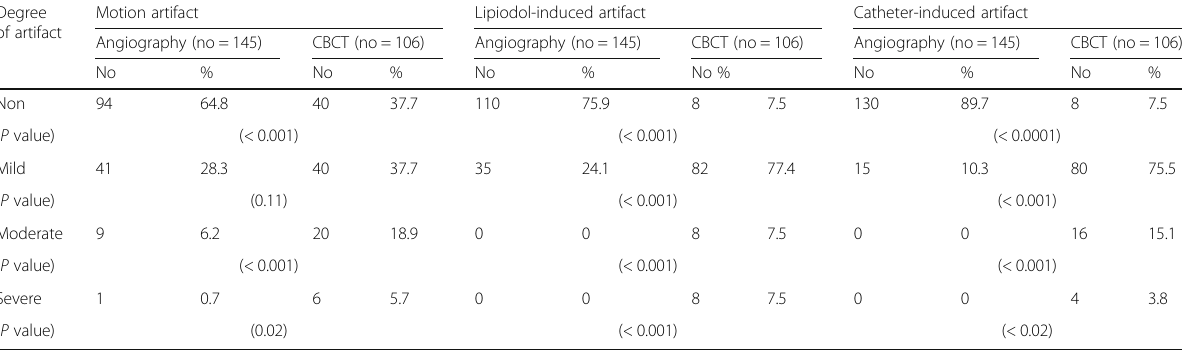
Table 1 Degree of image artifacts due to motion, catheter, and lipiodol in each acquisition taken by angiography and CBCT Degree Motion artifact Lipiodol-induced artifact Catheter-induced artifact of artifact